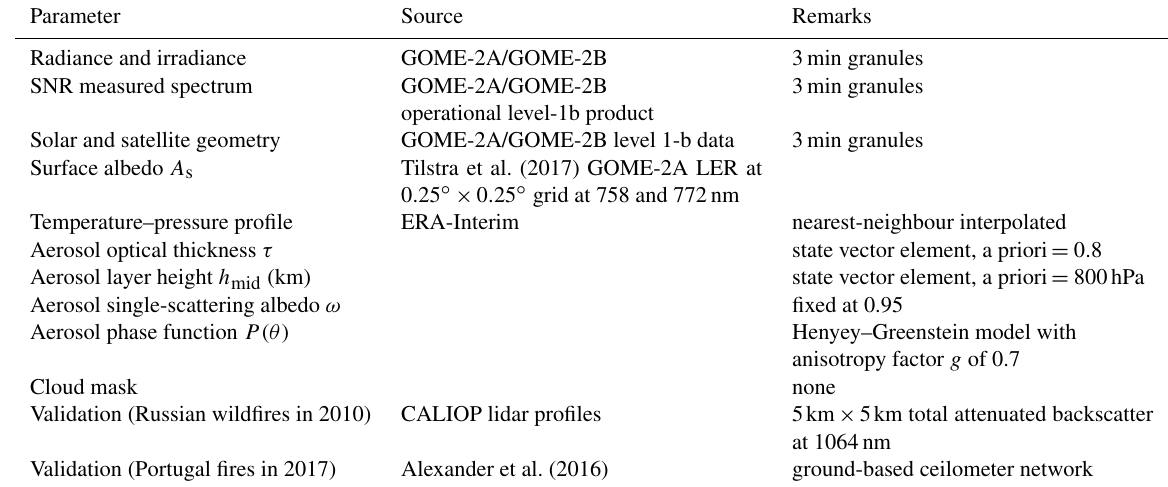
Table 3. Input data and algorithm set-up for retrieving aerosol properties from GOME-2 measurements in the oxygen A band.